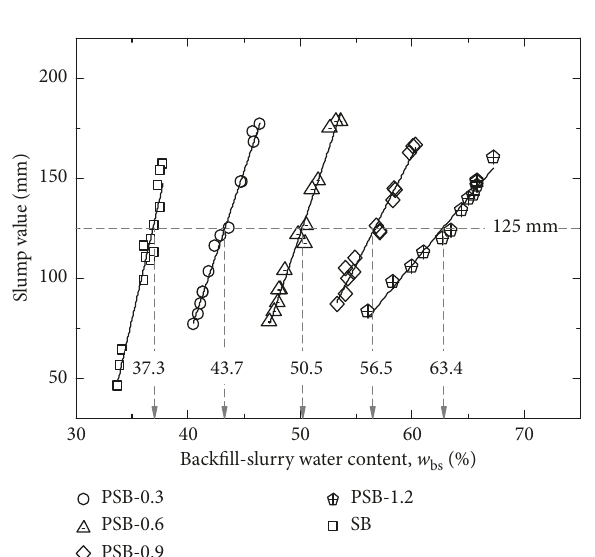
Figure 2: The slump values of SB and PSB with various polymer dosages.